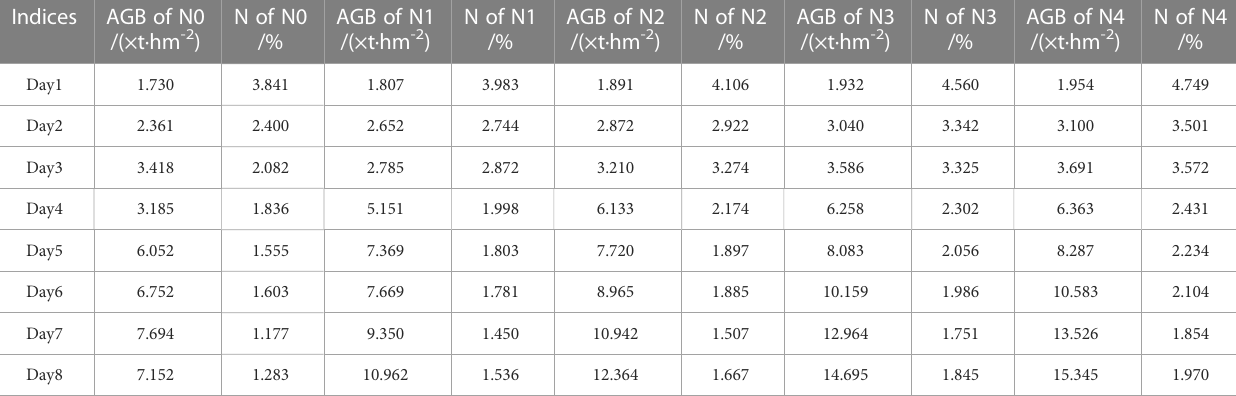
TABLE 2 AGB and N values for each period and each gradient of Experiment 1.